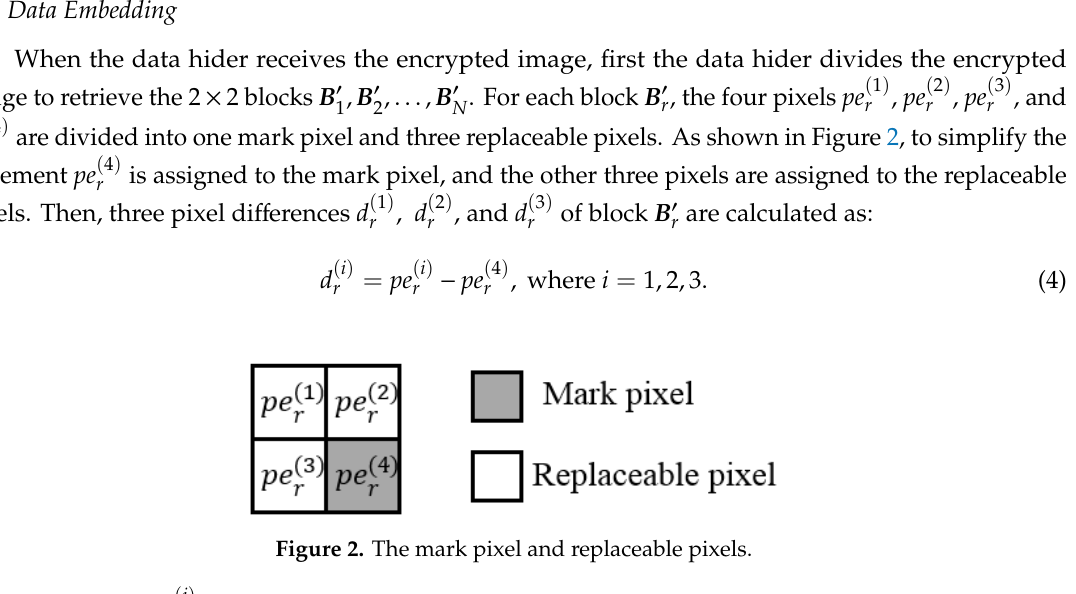
Figure 2. The mark pixel and replaceable pixels.